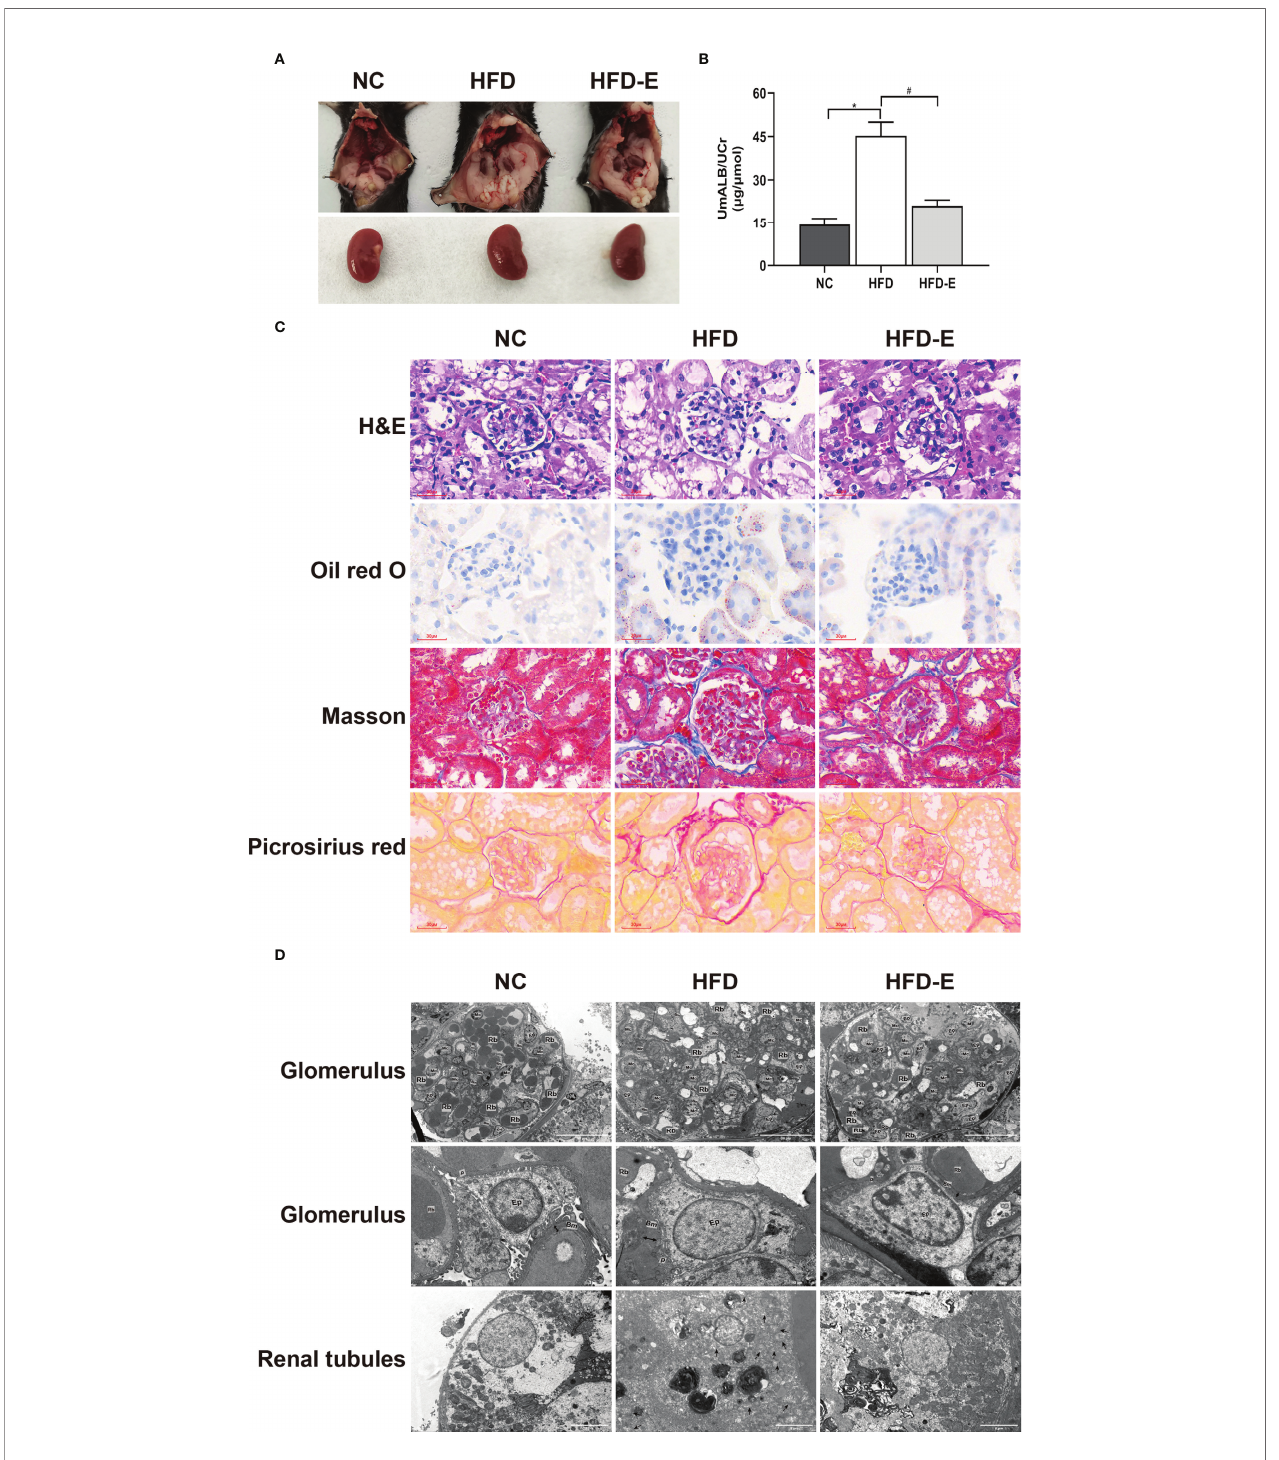
FIGURE 2 | EMPA improved kidney dysfunction and morphologic change. (A) Morphology of mice kidney. (B) The ratio of urinary albumin to creatinine (n= 6/ group). Data are means ± SEM. *P < 0.05 vs. NC; # P < 0.05 vs. HFD. (C) H&E, Oil red O, Masson trichrome and picrosirius red staining. Scale bar = 30 µm. (D) TEM images of glomerular and tubular structures. Scale bar = 20 µm, 2 µm and 5 µm. BM, basement membrane; Ep, epithelial cells; Rb, red blood cell; Mc, mesangial cells; P, podocyte; Double arrow, basement membrane thickness; * lipid drops; ↑ Damaged